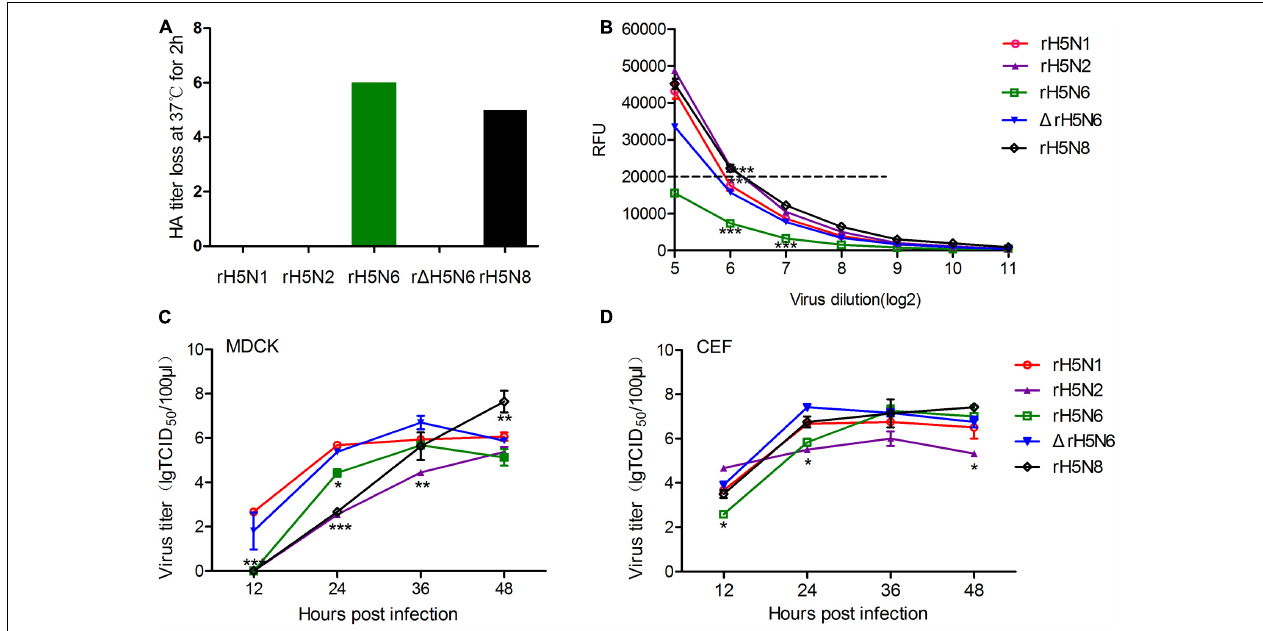
FIGURE 2 | Hemagglutinin (HA)-neuraminidase (NA) properties and growth kinetics of H5Nx reassortant viruses. (A) Elution assays of guinea pig RBCs. H5Nxreassortant viruses were serially diluted in phosphate-buffered saline (PBS) and incubated with 0.8% RBC suspensions at 4 ◦ C for 75 min, then 37 ◦ C for 2 h. And then the loss of HA activity was recorded. Each virus was analyzed in triplicate wells. (B) NA activity was measured by a solution assay using the fluorescence substrate 4-MU-NANA. NA activity was represented by the fluorescence intensity represent the NA activity ( ∗∗ P < 0.01, ∗∗∗ P < 0.001). (C) Madin-Darby canine kidney (MDCK) cells were inoculated with viruses at an multiplicity of infection (MOI) of 0.001. (D) Chicken Embryo Fibroblast (CEF) was inoculated with viruses at an MOI of 0.0001. Samples were collected at 12, 24,36, and 48 hour post-inoculation (h.p.i.). Virus titers were determined by using the 50% tissue culture infectious dose (TCID 50 ) assay. The virus titers are means ± standard deviations (SD) ( n = 3), Statistical significance was analyzed using an unpaired t -test: ∗ P < 0.05, ∗∗ P <